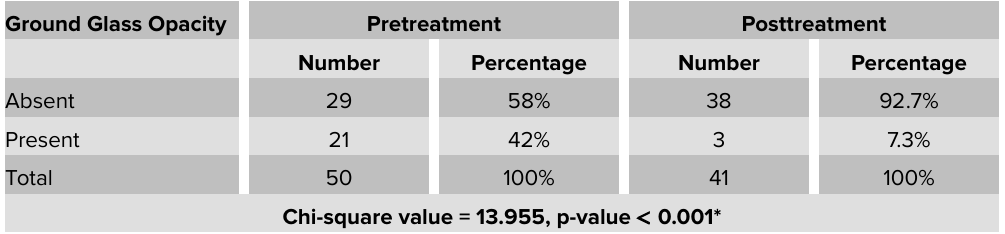
TABLE 5: Frequency distribution ground glass opacification in pre- and posttreatment cases.